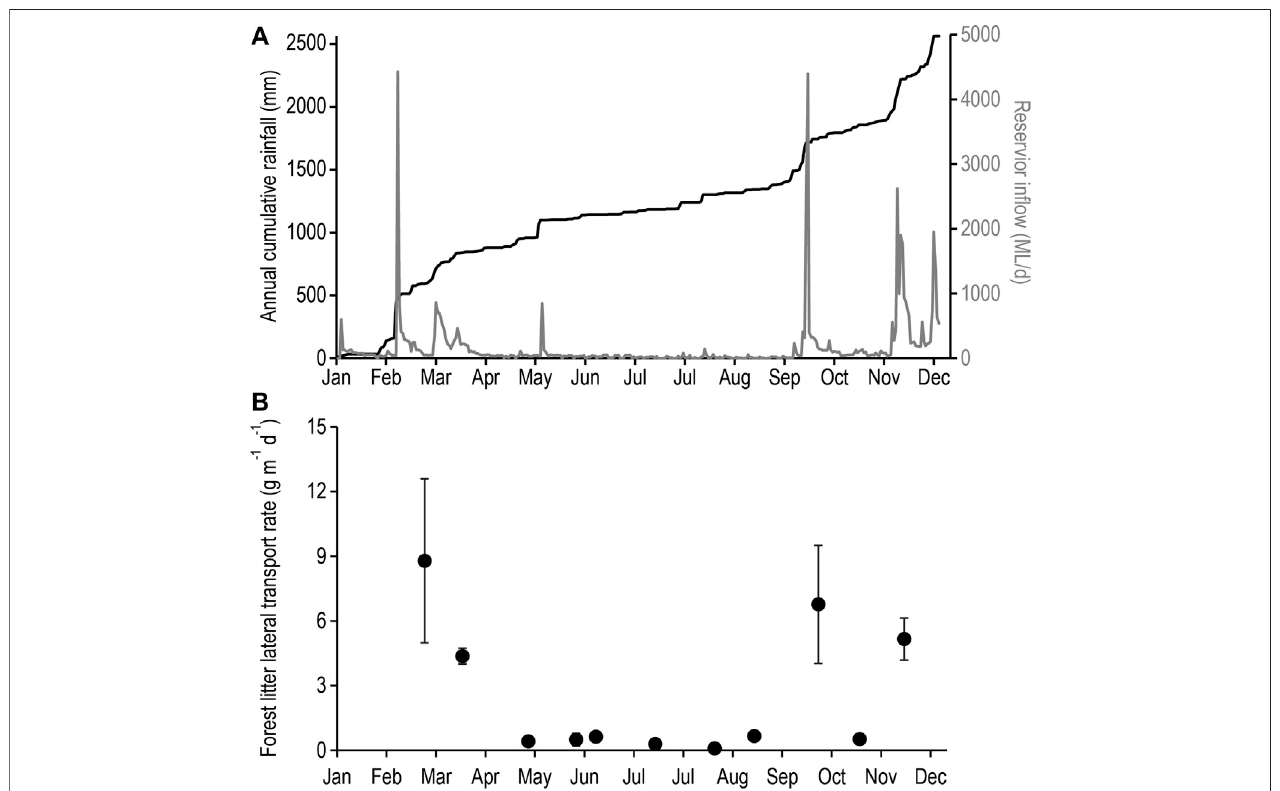
FIGURE 4 | (A) Cumulative rainfall (black line) and catchment in fl ow (grey line); and (B) forest litter lateral transport rate per unit shoreline (g m -1 shoreline d -1 ) from Little Nerang Dam across the 2010 annual cycle.